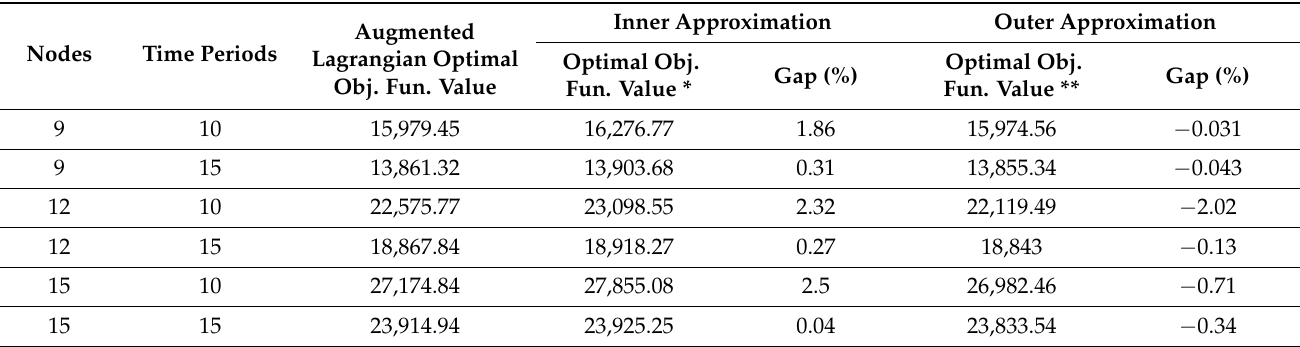
Table 10. Objective function values obtained from augmented Lagrangian, inner approximation, and outer approximation.